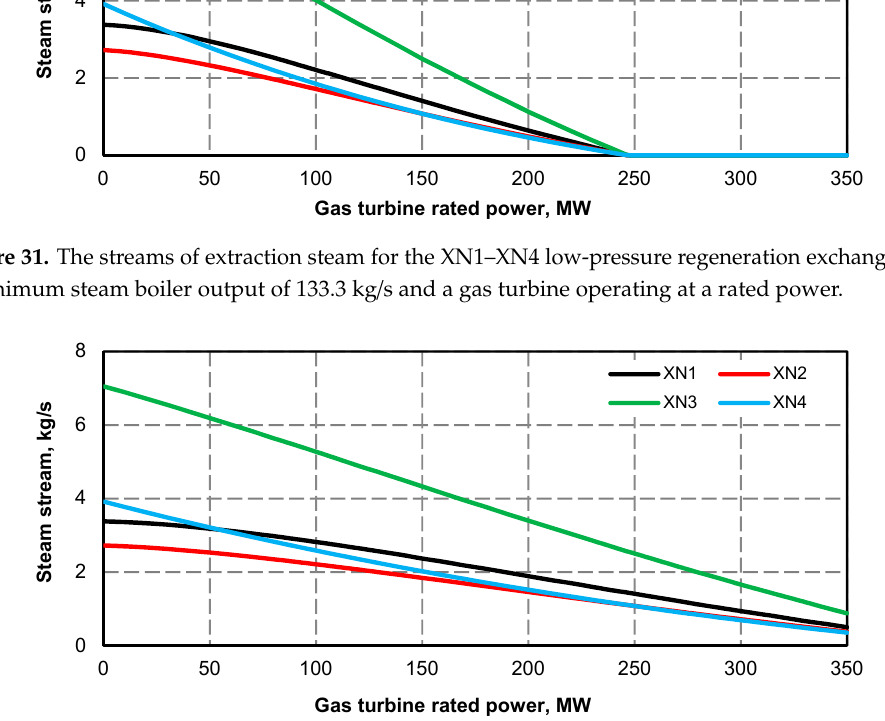
Figure 32. The streams of extraction steam for the XN1–XN4 low-pressure regeneration exchangers for a minimum steam boiler output of 133.3 kg/s and gas turbine operating at 60% of its rated power.